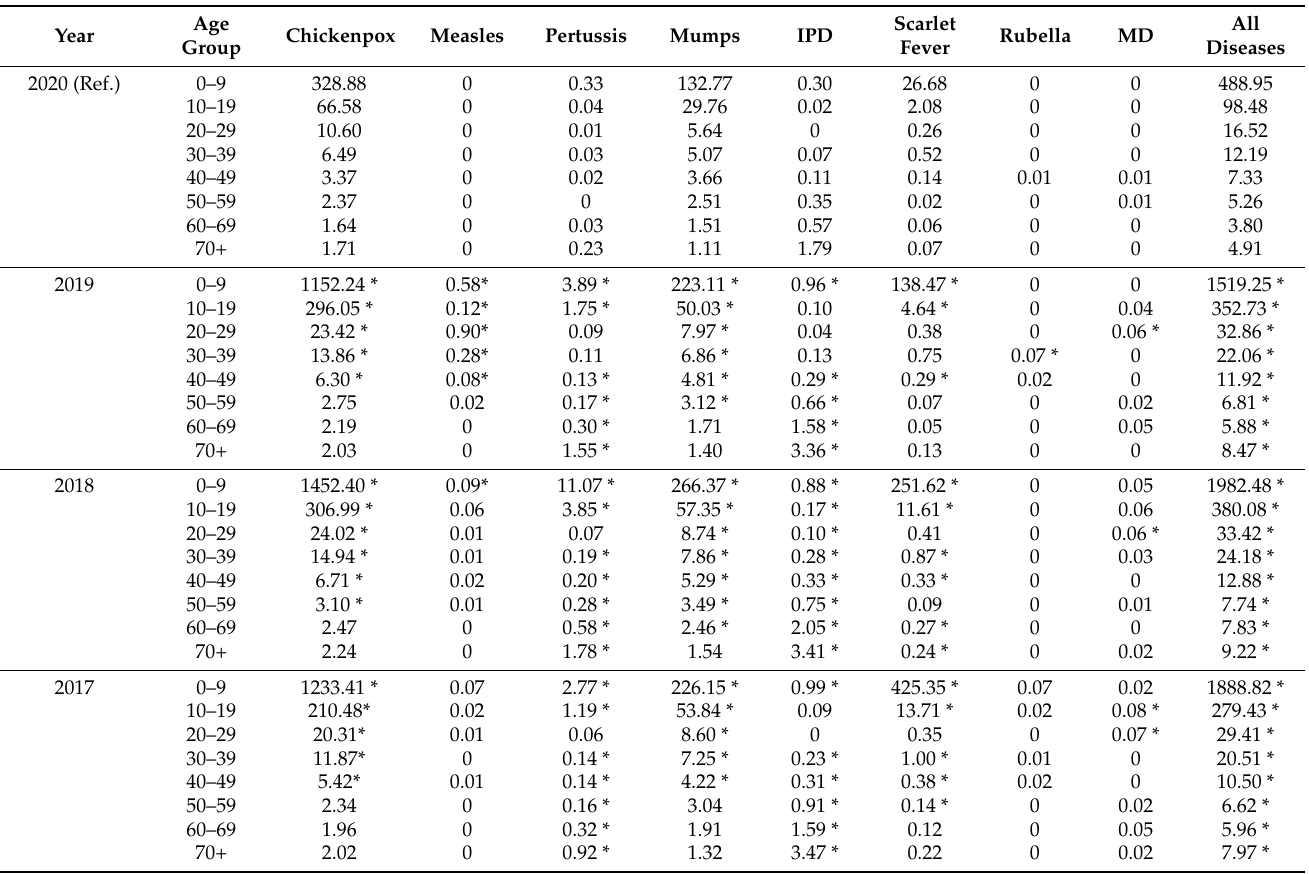
Table A1. IRs of eight infectious respiratory diseases in intervention and pre-intervention periods by each age group.